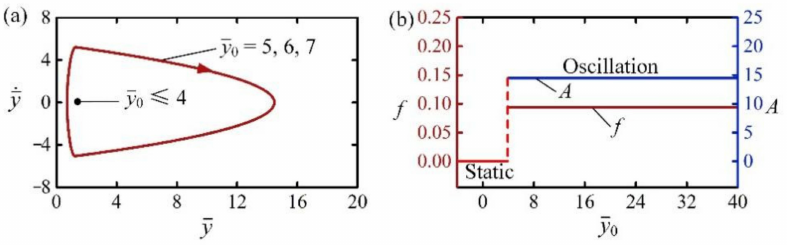
Figure 5. The effect of initial position on the self-jumping for C 0 = 0.3, I 0 = 2, H = 4, β = 0.01, g = 1, = 0.5, E = 500, and n g = 200, p am exists a critical y to trigger the self-jumping, and y 0